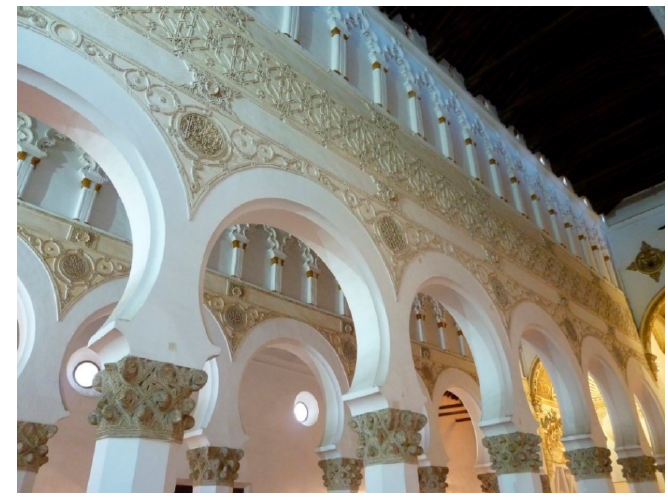
Figure 24. Interior of the Santa María la Blanca synagogue of Toledo. Author’s photo.